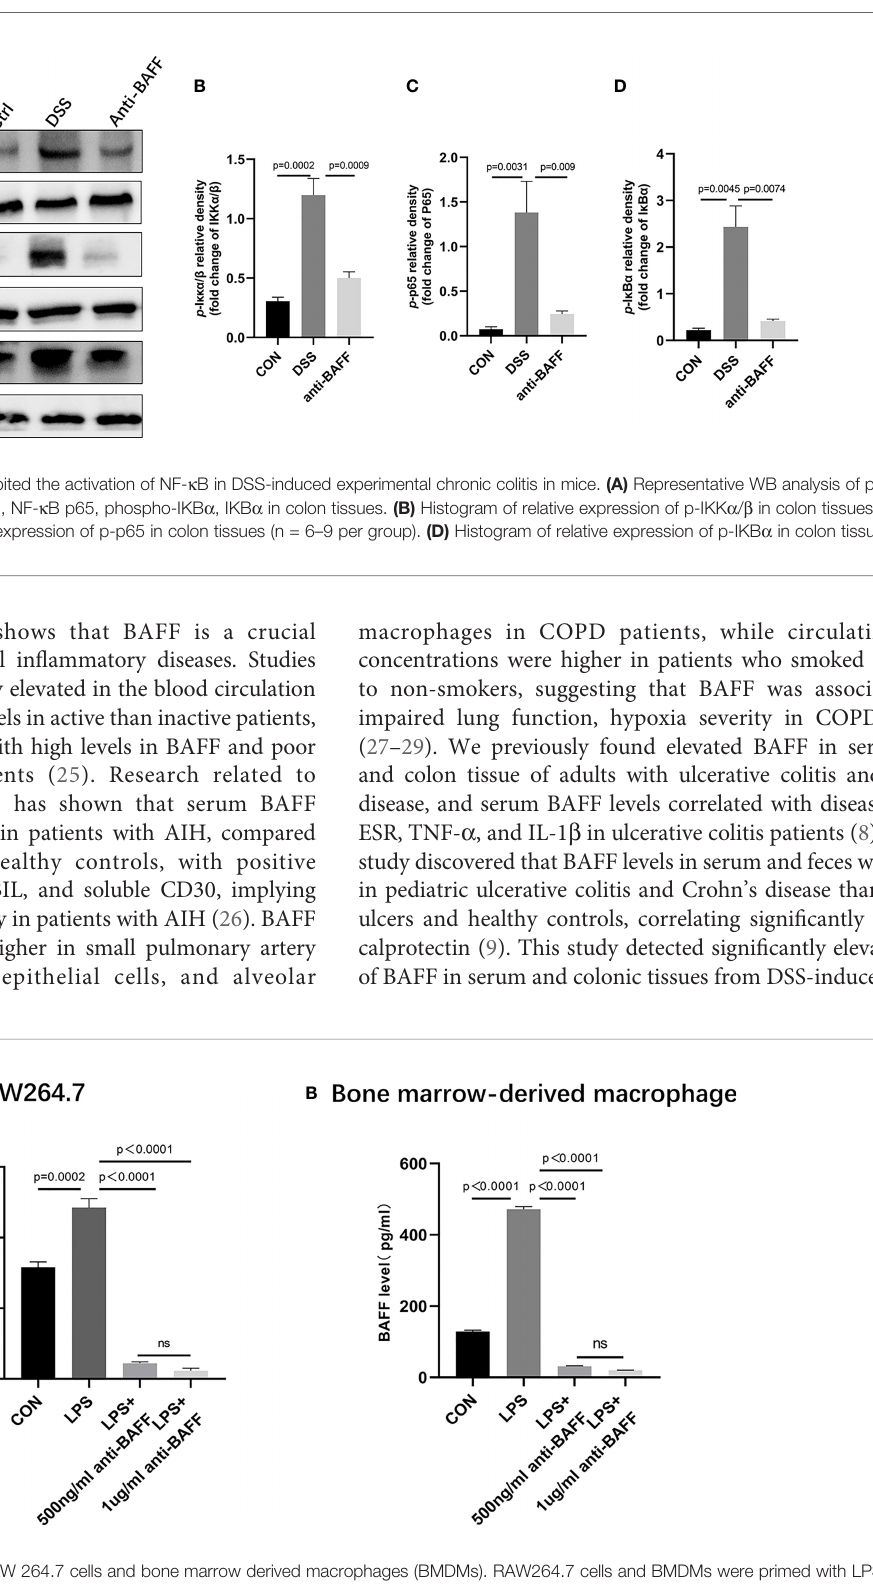
FIGURE 6 | Secretion of BAFF in RAW 264.7 cells and bone marrow derived macrophages (BMDMs). RAW264.7 cells and BMDMs were primed with LPS (1 m g/ml) for 6 h. Anti-BAFF antibody or mouse immunoglobulin G1 (IgG1) isotype control antibody (500 ng/ml or 1 ug/ml) was added to RAW 264.7 and BMDMs at the same time with LPS. (A) Detection of BAFF by ELISA in RAW264.7 cells. (B) Detection of BAFF by ELISA in BMDMs. ns, P > 0.05.